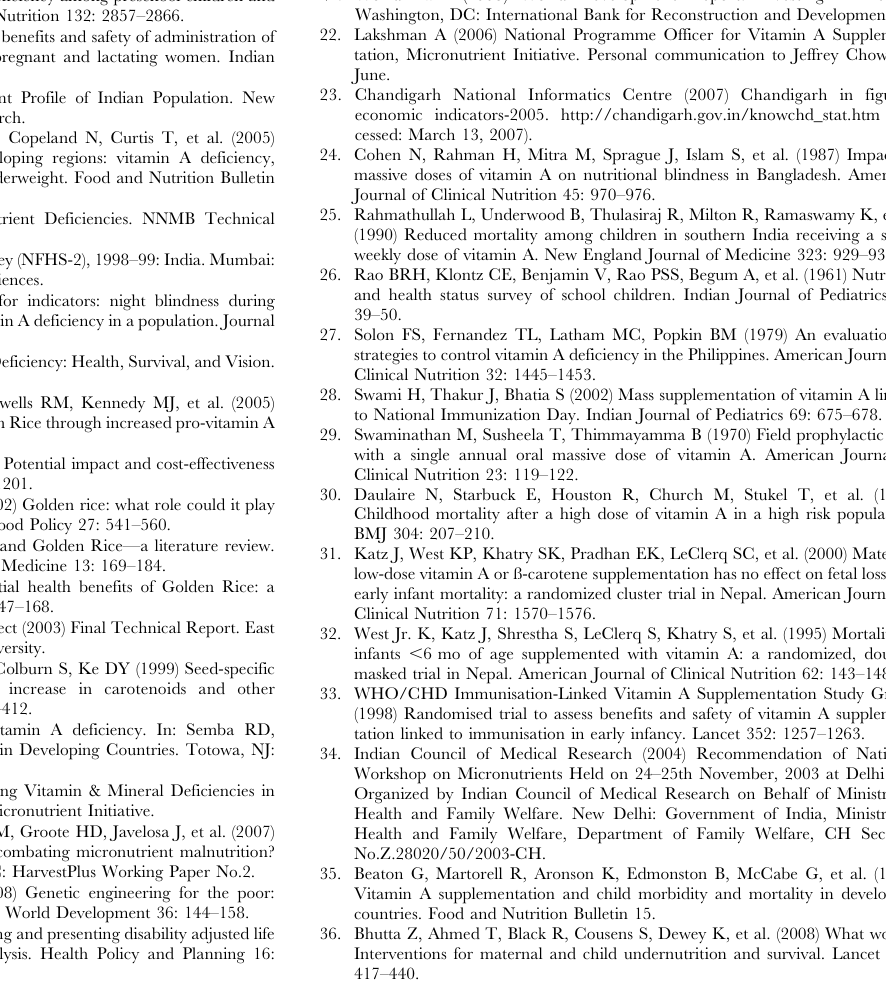
Table S1 Parameter values for sensitivity analysis.